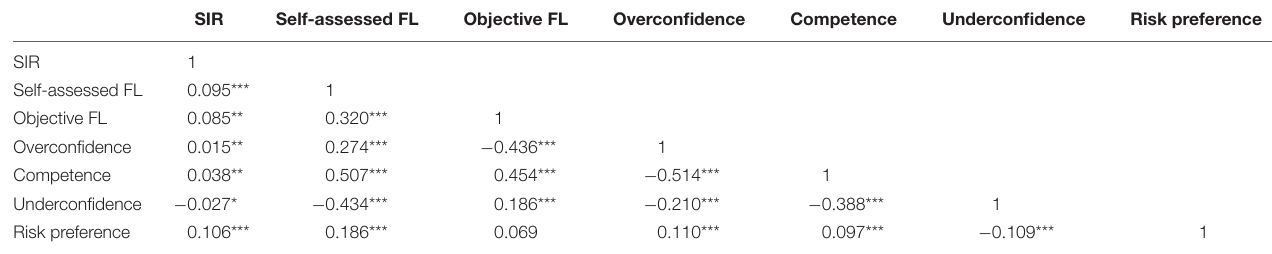
TABLE 6 | The correlation analysis of some core